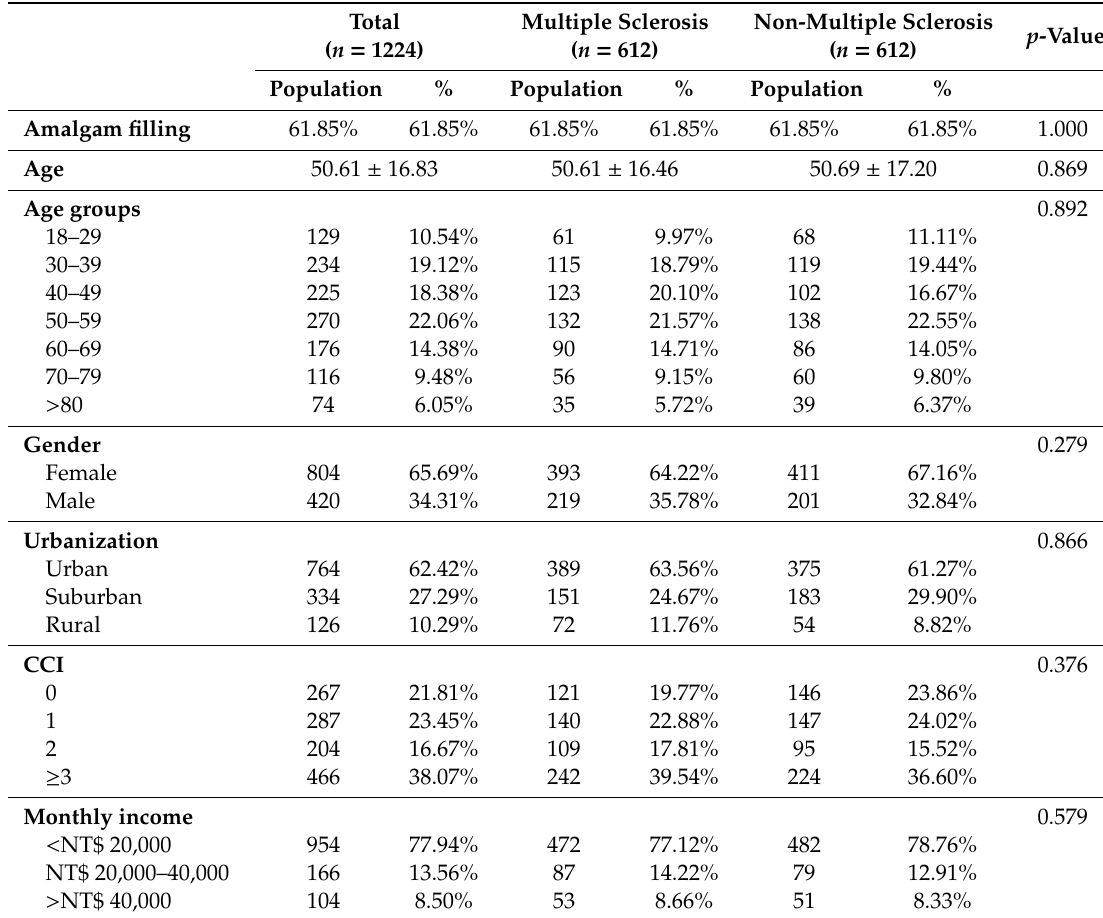
Table 1. Demographic characteristics of individuals in this